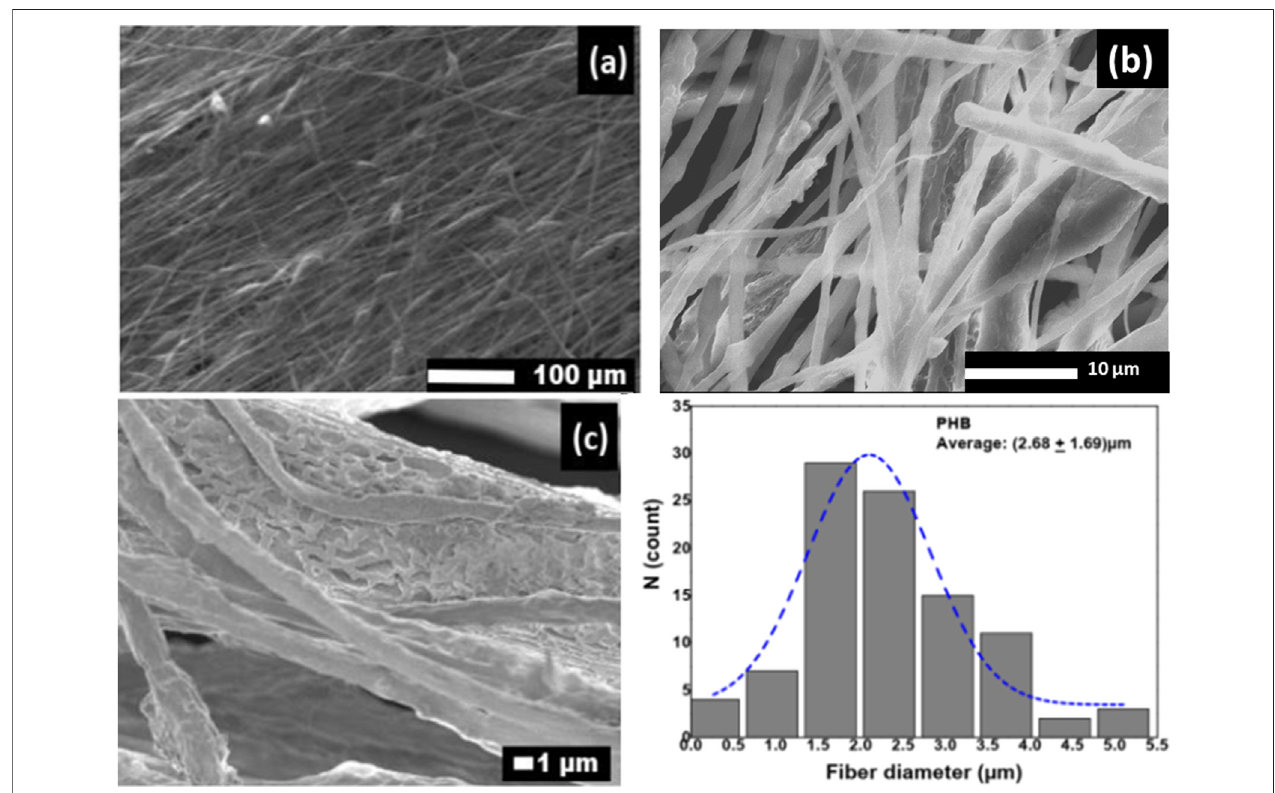
FIGURE 6 | SEM images (A – C) of PHB scaffold and (D) fi ber diameter